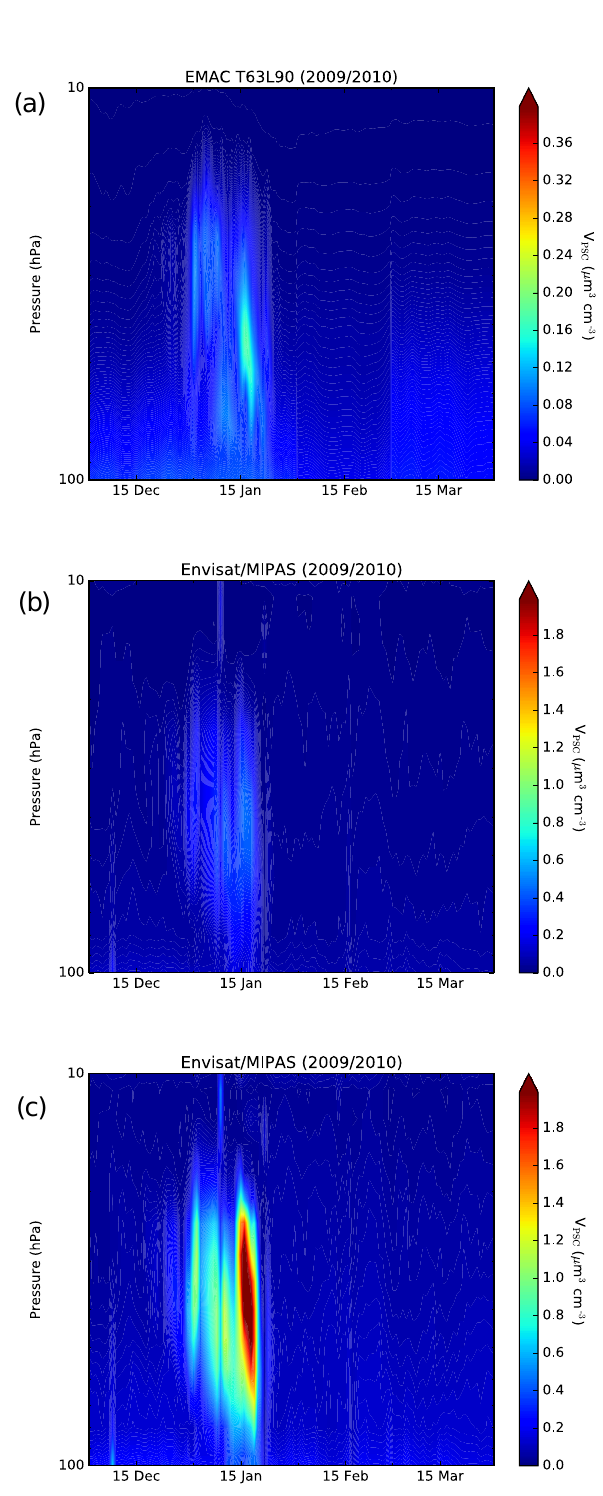
Figure 4. Volume density of all (liquid and solid) PSC particles ( V PSC ) in µm 3 cm − 3 as simulated with EMAC (a) and observed with Envisat/MIPAS lower limit (b) and Envisat/MIPAS upper limit (c) for the Arctic winter 2009/2010. Note the different colour bar scales between the Envisat/MIPAS and EMAC